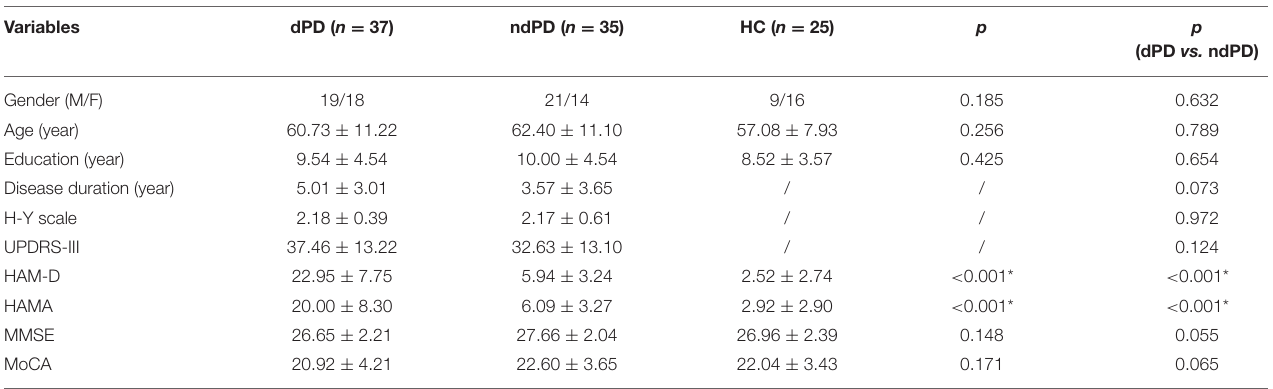
TABLE 1 | Demographic and clinical characteristics of all